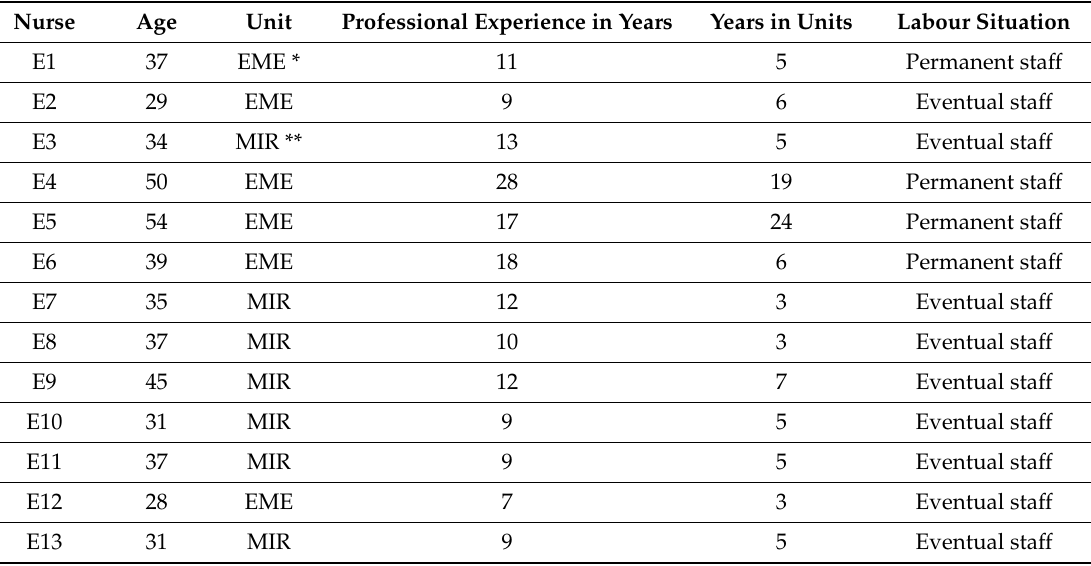
Table 2. Sociodemographic characteristics of the